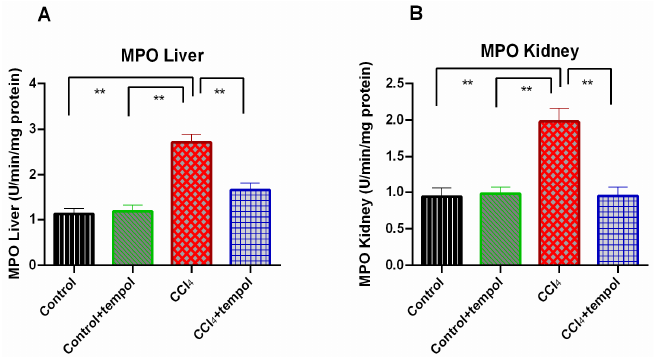
Figure 6. Effect of tempol on MPO liver and MPO kidney in CCl 4 -administered rats. Every value was represented as mean ± SEM. Every value was represented as mean ± SEM. N = 6. One-way ANOVA followed by Tukey’s test were performed for statistical analysis. For statistical significance, p < 0.05 is considered significant in all cases. Here, ** means p < 0.001.